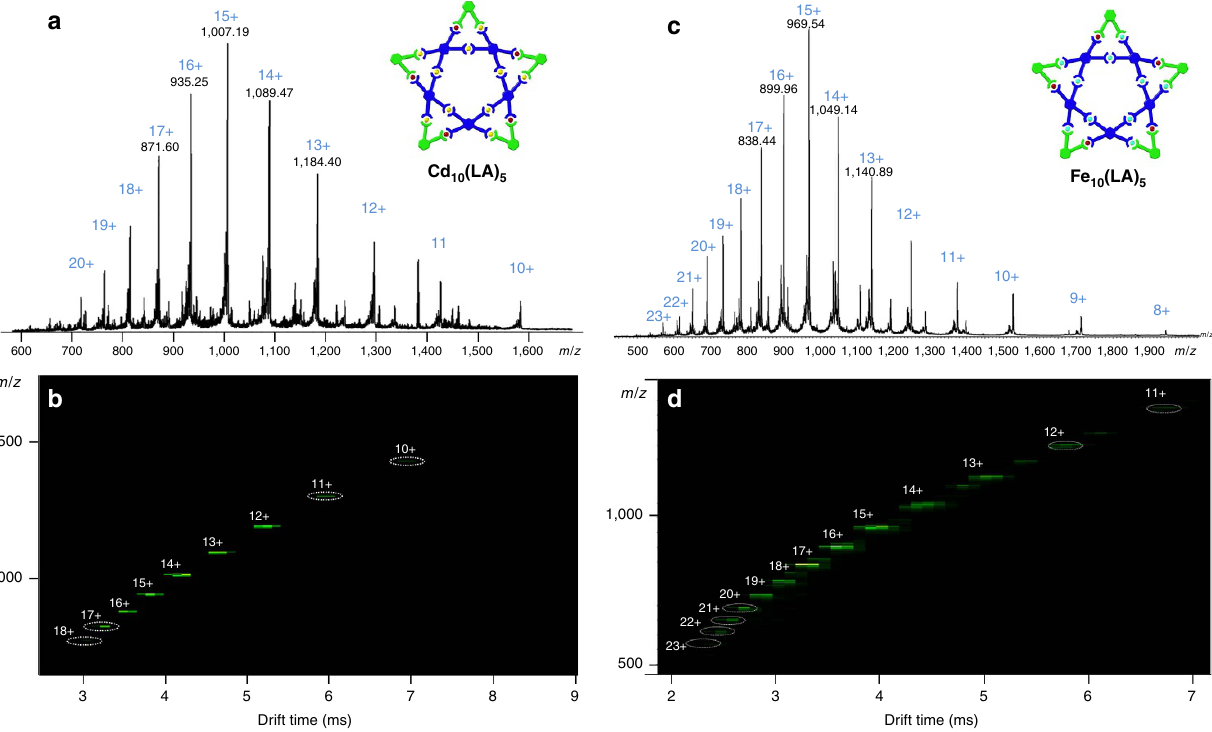
Figure 3 | ESI/TWIM-MS spectrum. ( a ) ESI-MS and ( b ) TWIM-MS of pentagonal [Cd 10 LA 5 ) ] 30 þ ; ( c ) ESI-MS and ( d ) TWIM-MS of pentagonal [Fe 10 LA 5 ] 30 þ